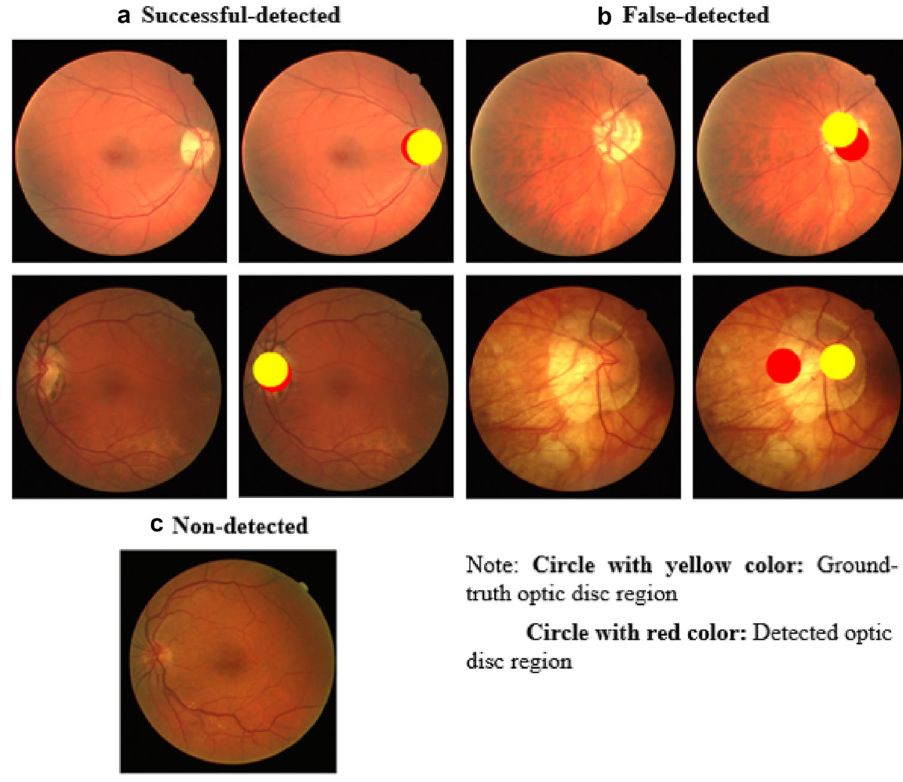
Fig. 6 Sample results